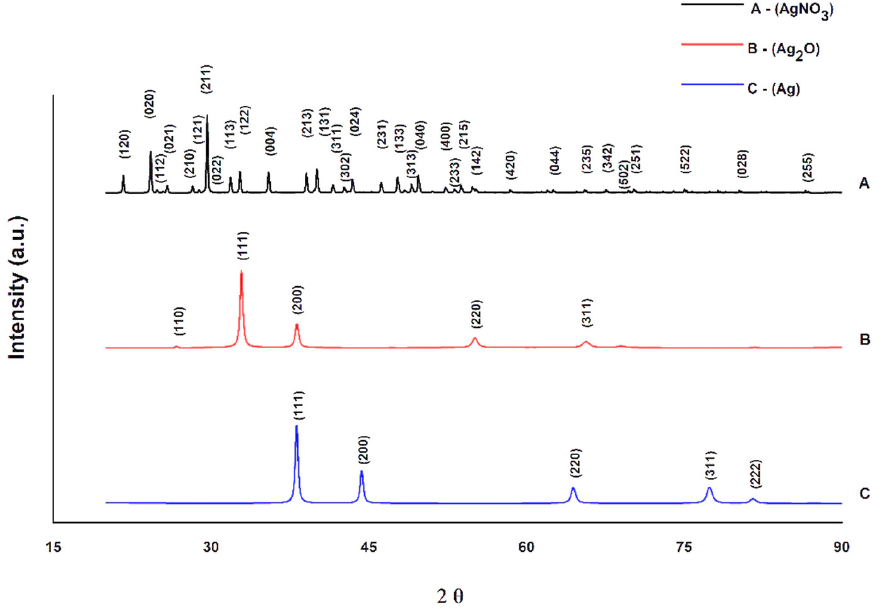
Figure 2. Diffractogram from silver nitrate (AgNO 3 ) as–received samples, silver oxide (Ag 2 O), and silver (Ag).